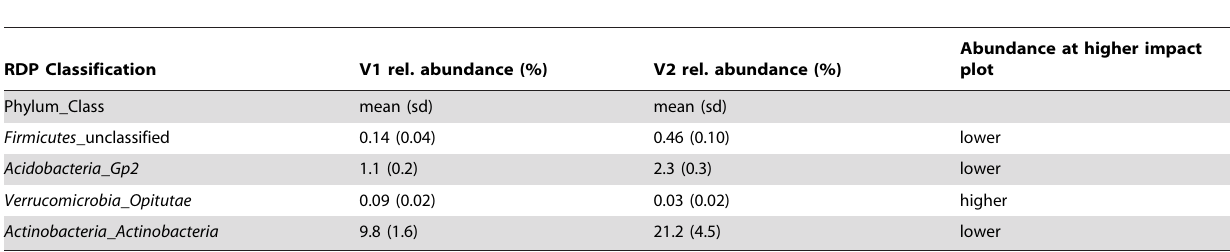
Table 4. Bacterial phylotypes at the Class level with differing abundance between Vohibe high impact (V1) and low impact (V2) sites (Metastats p , 0.05).